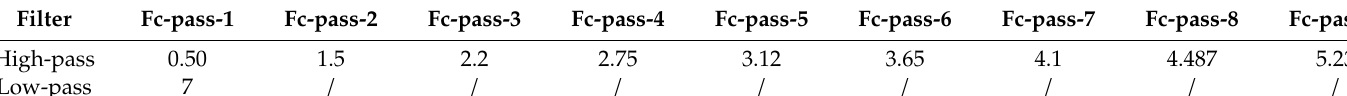
Table 3. Hyper High-pass filtering setup (in Hz).